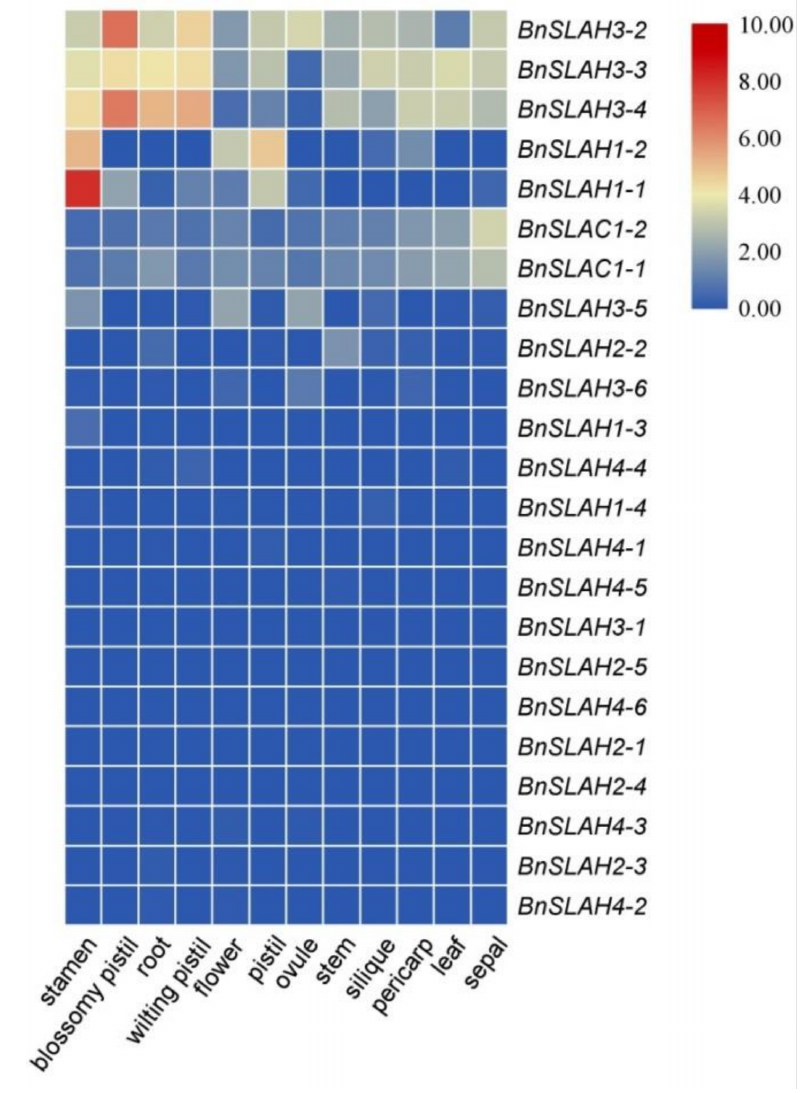
Figure 8. In leaves, the expression level of the BnSLAC1-1 and BnSLAH3-2 increased about 10 and 5 folds after 7 d LN treatment. In addition, the expression level of BnSLAH1-1 and BnSLAH3-3 evaluated about 2 to 4 folds after 3 h and 12 h LN treatment while that of BnSLAH3-4 had no obvious change. In roots, the expression of BnSLAC1-1 was increased 3.5 times at 24 h after LN treatment but not significantly changed at other treatment time points. The expression levels of BnSLAH1-1 were significantly up-regulated especially at 3 h after low nitrogen treatment. In addition, BnSLAH3-2 was significantly up-regulated 2 to 3 times under 12 h and 24 h low N treatment. Besides, 3 h and 12 h LN treatment induced a 2 to 4-fold up-regulation of BnSLAH3-3 and BnSLAH3-4 expression. Therefore, the slow anion channel proteins are able to respond to low nitrogen signal in a short time, which may be involved in nitrate uptake and transport in B. napus .